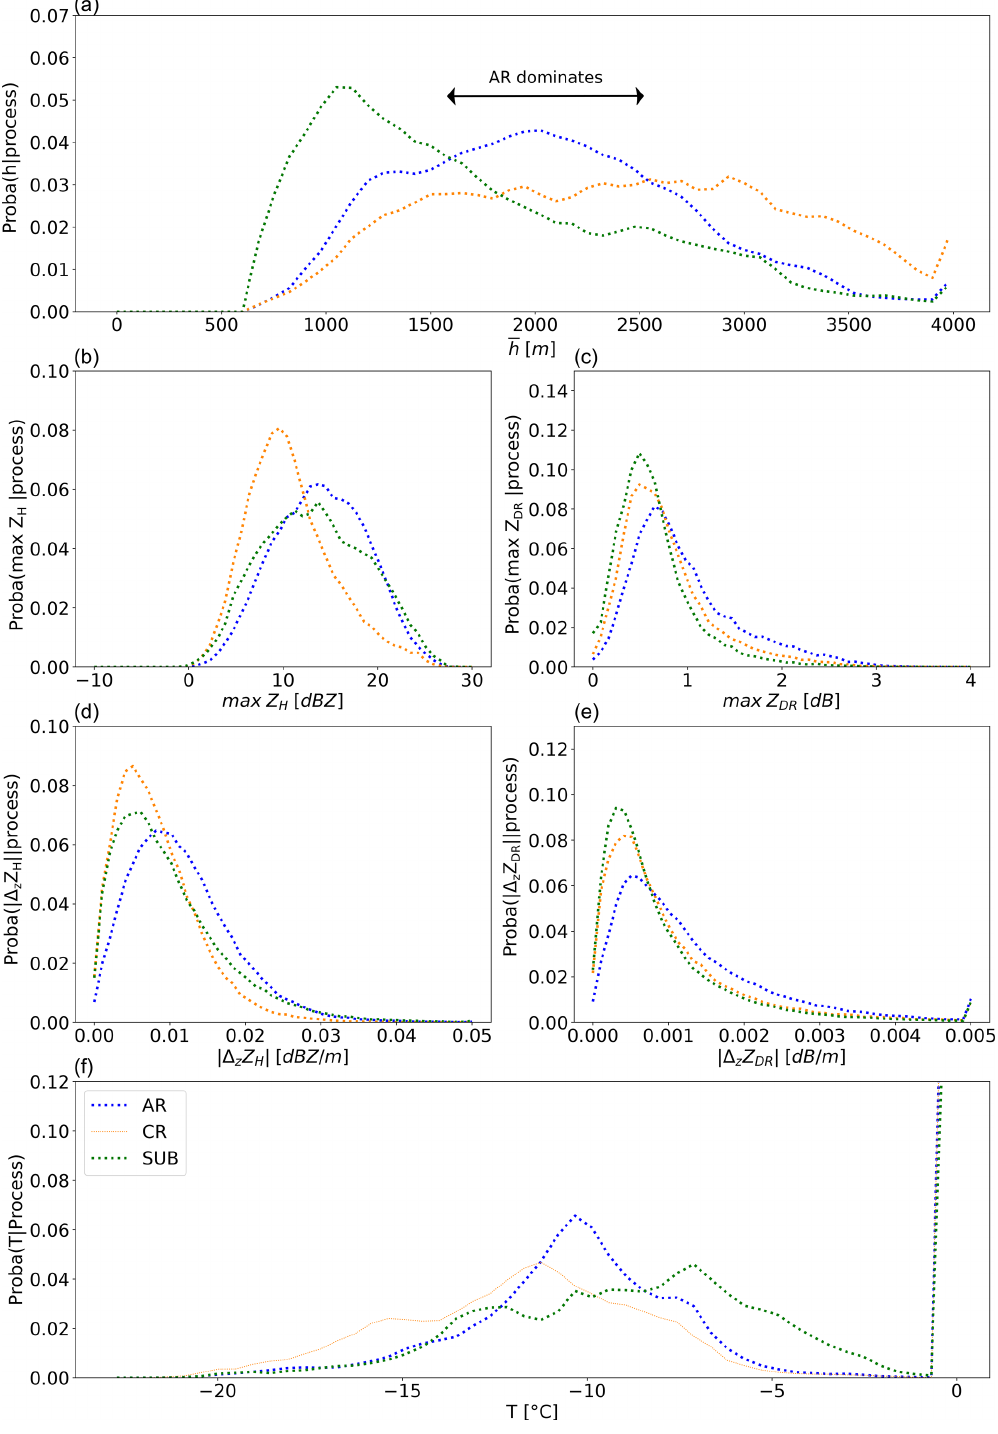
Figure 7. Empirical conditional probability distributions for EV1. (a) Mean height of process occurrence a.g.l. h . (b, c) Absolute maximal value of Z H and Z DR . (d, e) Absolute value of the mean local vertical gradient of Z H and Z DR . (f) Probability of temperature conditioned to different processes. The distributions are computed over all the sections of profiles identified as AR (blue), CG (orange) and SUB